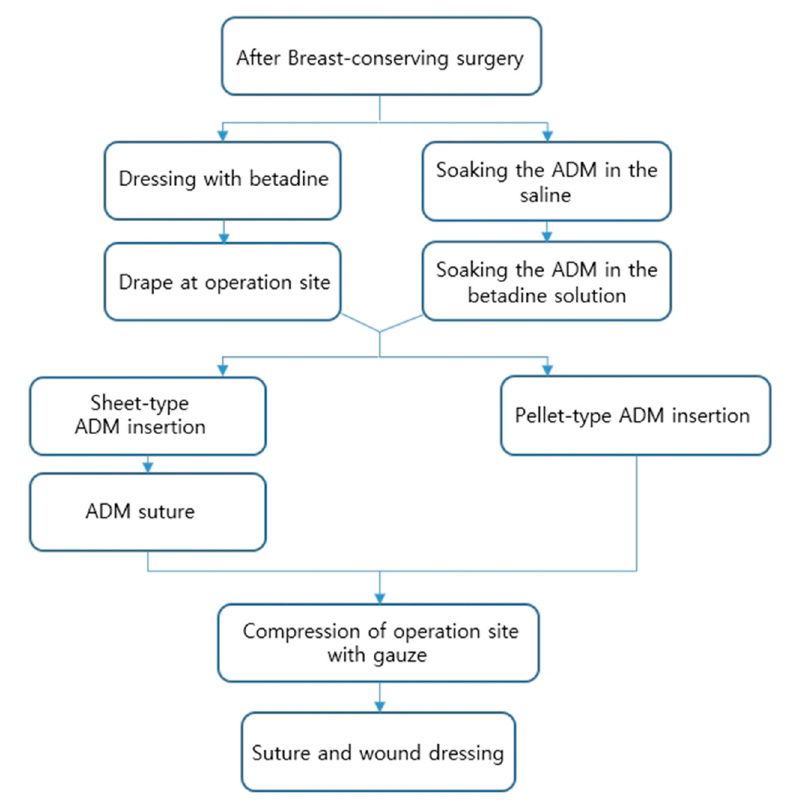
Figure 1. Surgical order of breast reconstruction using two types of ADM. ADM = acellular dermal matrix.